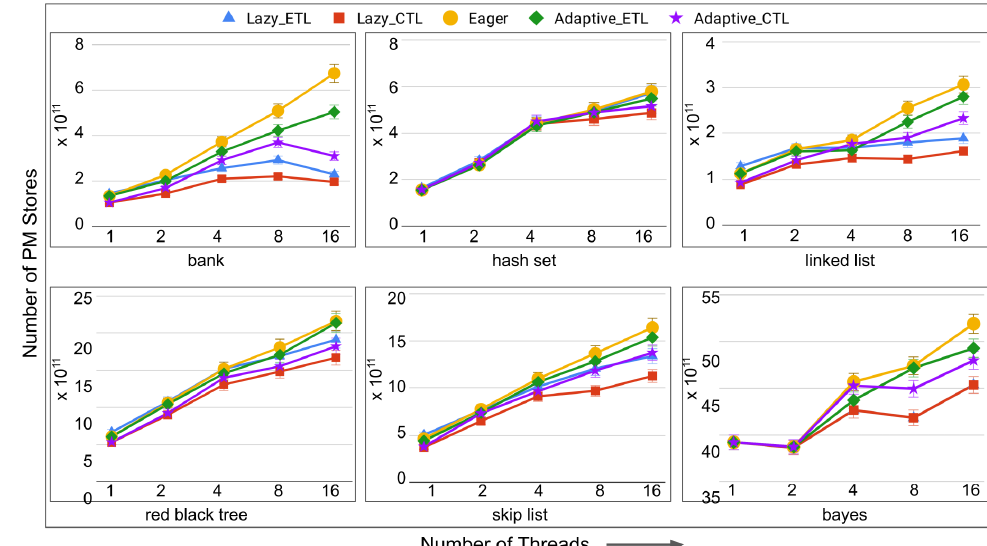
Figure 8. Total number of stores to the PM in micro-benchmarks and bayes from